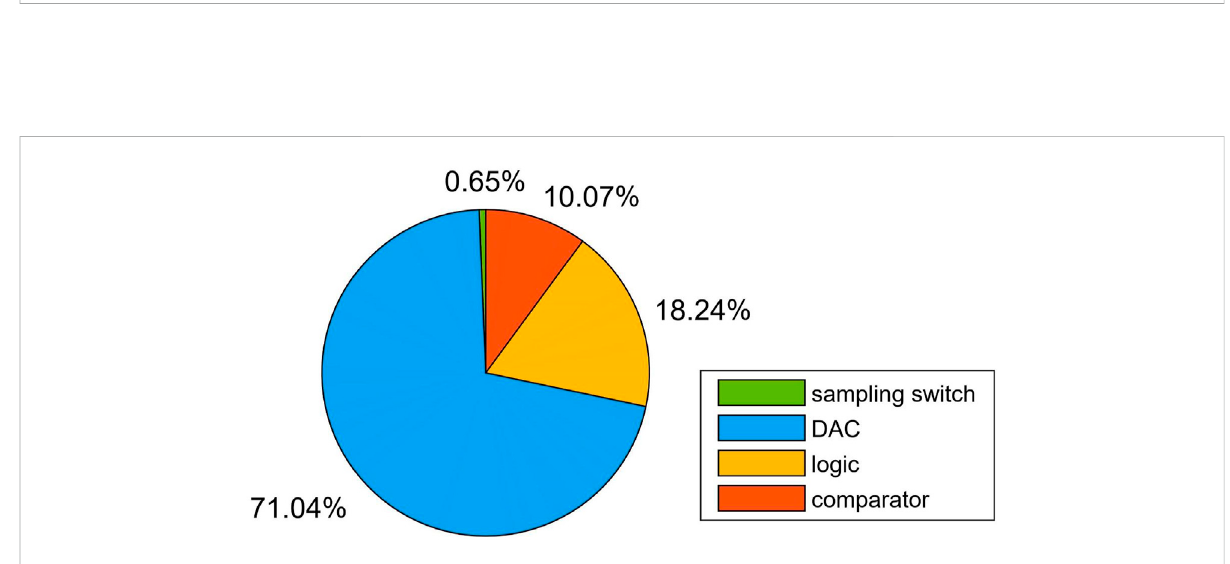
FIGURE 15 Power breakdown of the